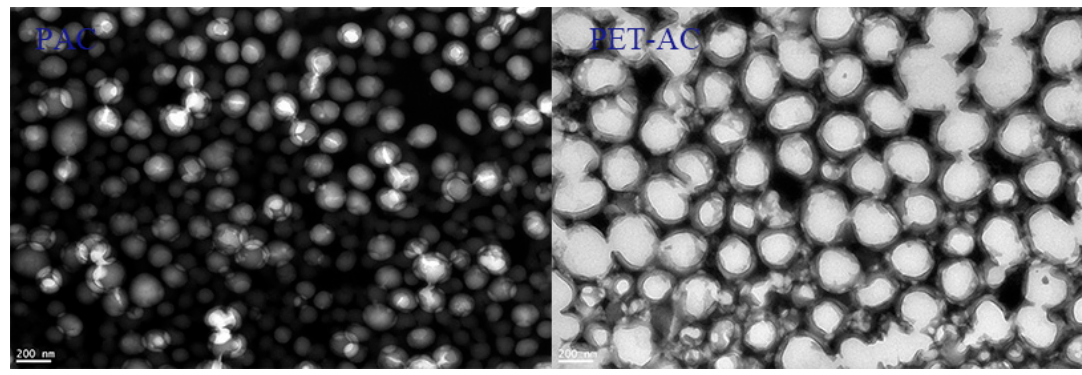
Figure 9. TEM micrograph of the PAC and PET-AC latex particles.